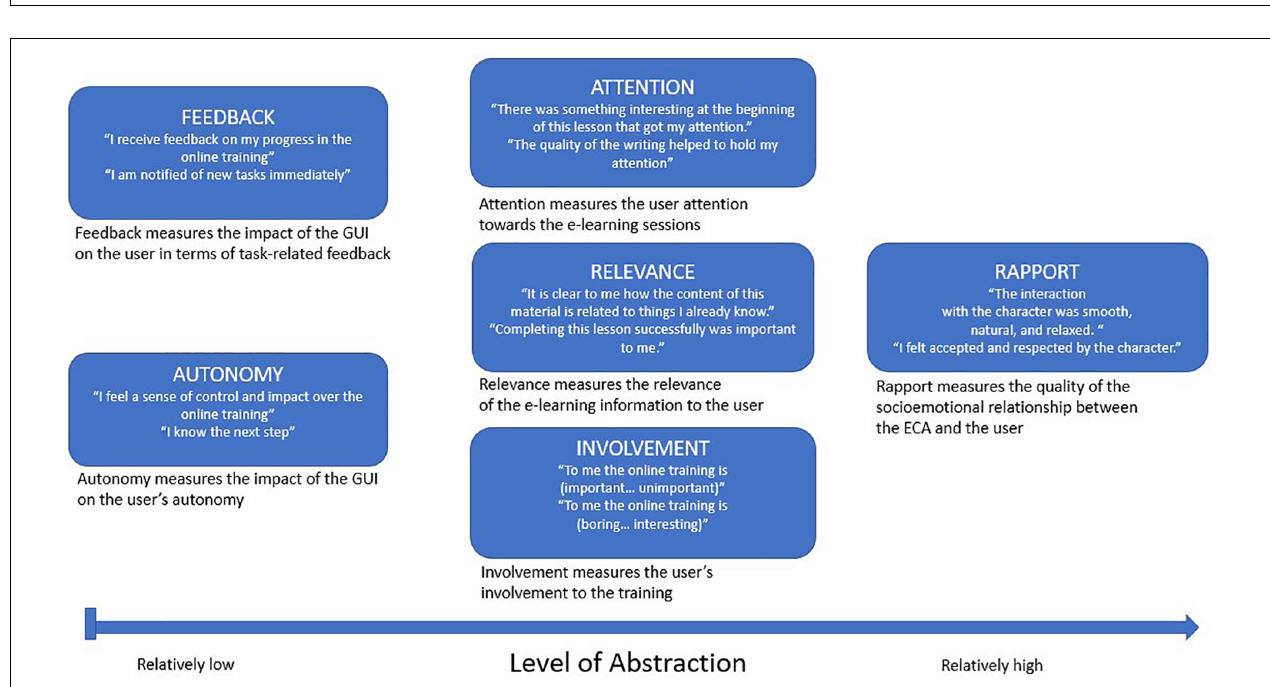
FIGURE 4 | Interaction effect of visibility ∗ gender type for the feedback variable.